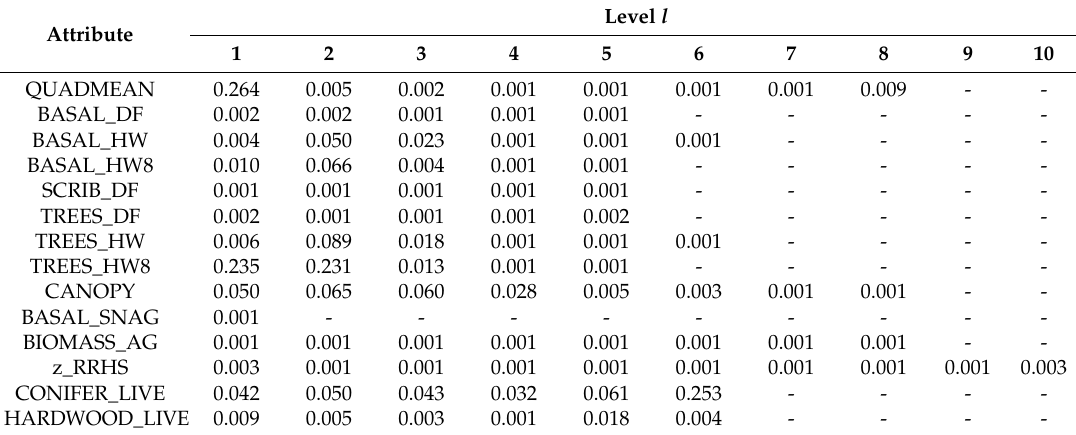
Table 2. p -Values for attributes at level l for den NCs compared to forest